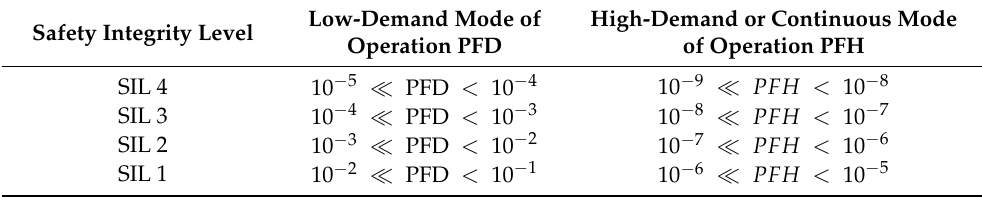
Table 8. Safety integrity levels: Target failure measures for safety function